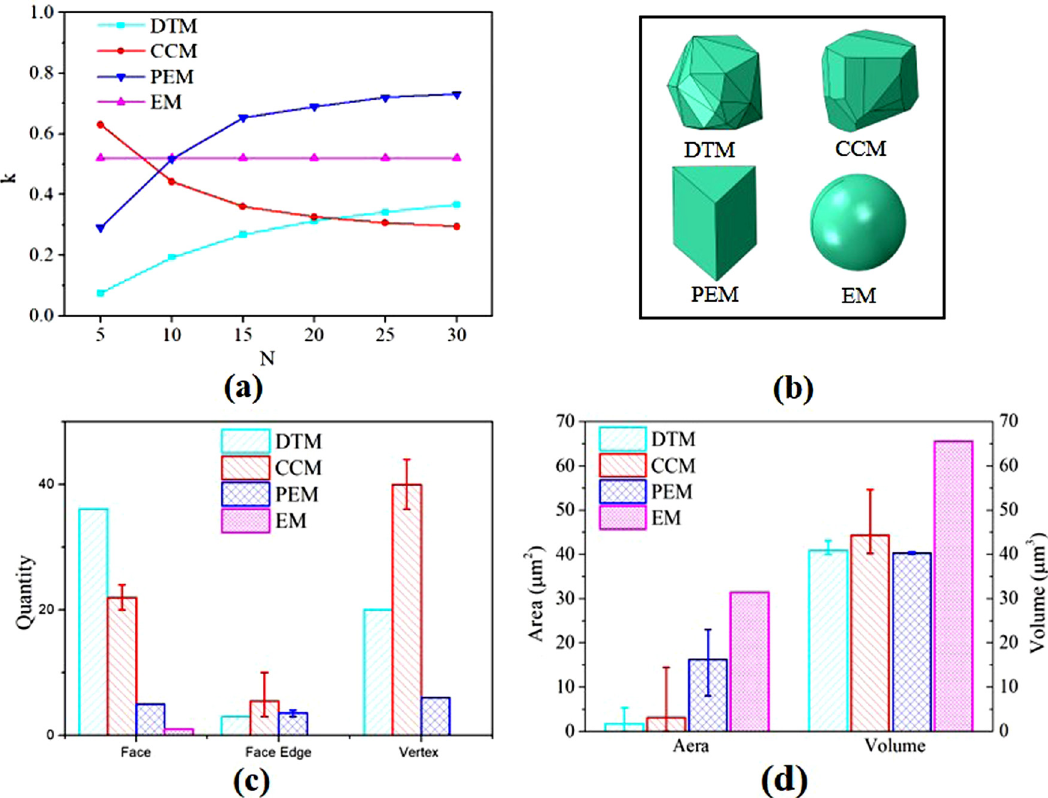
Figure 5: ( a ) N – k curve, ( b ) particle morphology, ( c ) histogram of the quantity of face, face edge, and vertex, and ( d ) histogram of face area and